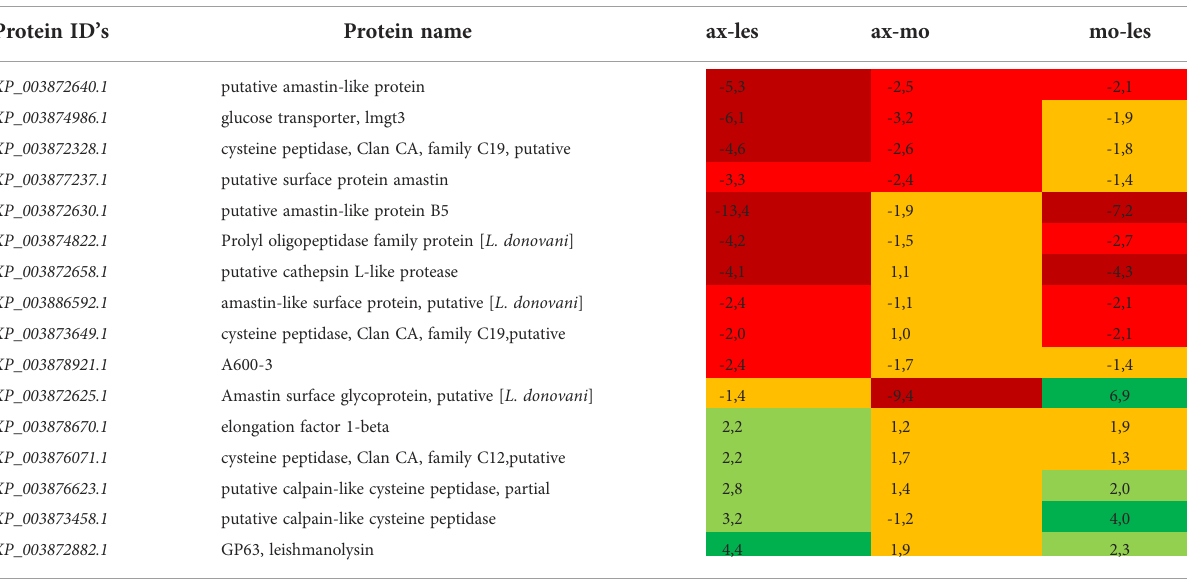
TABLE 1 Virulence factors identi fi ed in all 3 comparisons that differ by at least 2-fold (T-test signi fi cant) between individual amastigote types. Virulence factors